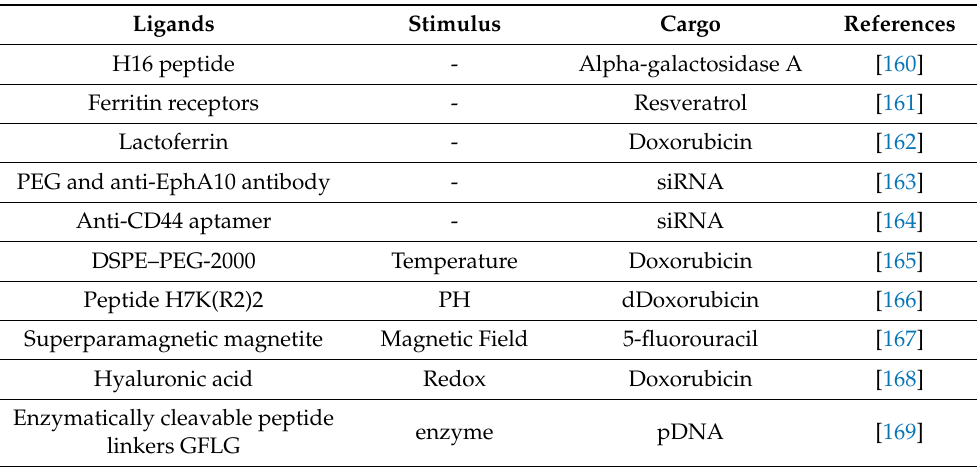
Table 6. Various ligands modified liposomes to deliver different